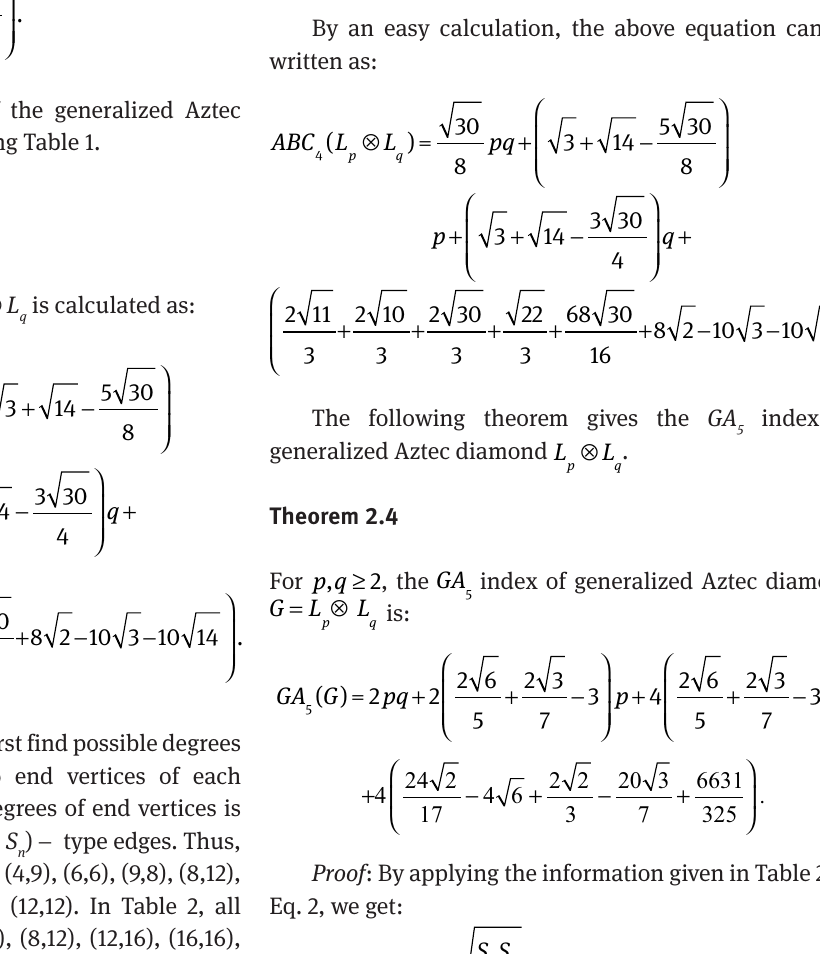
⊗ L , S )of L , where m m n p q